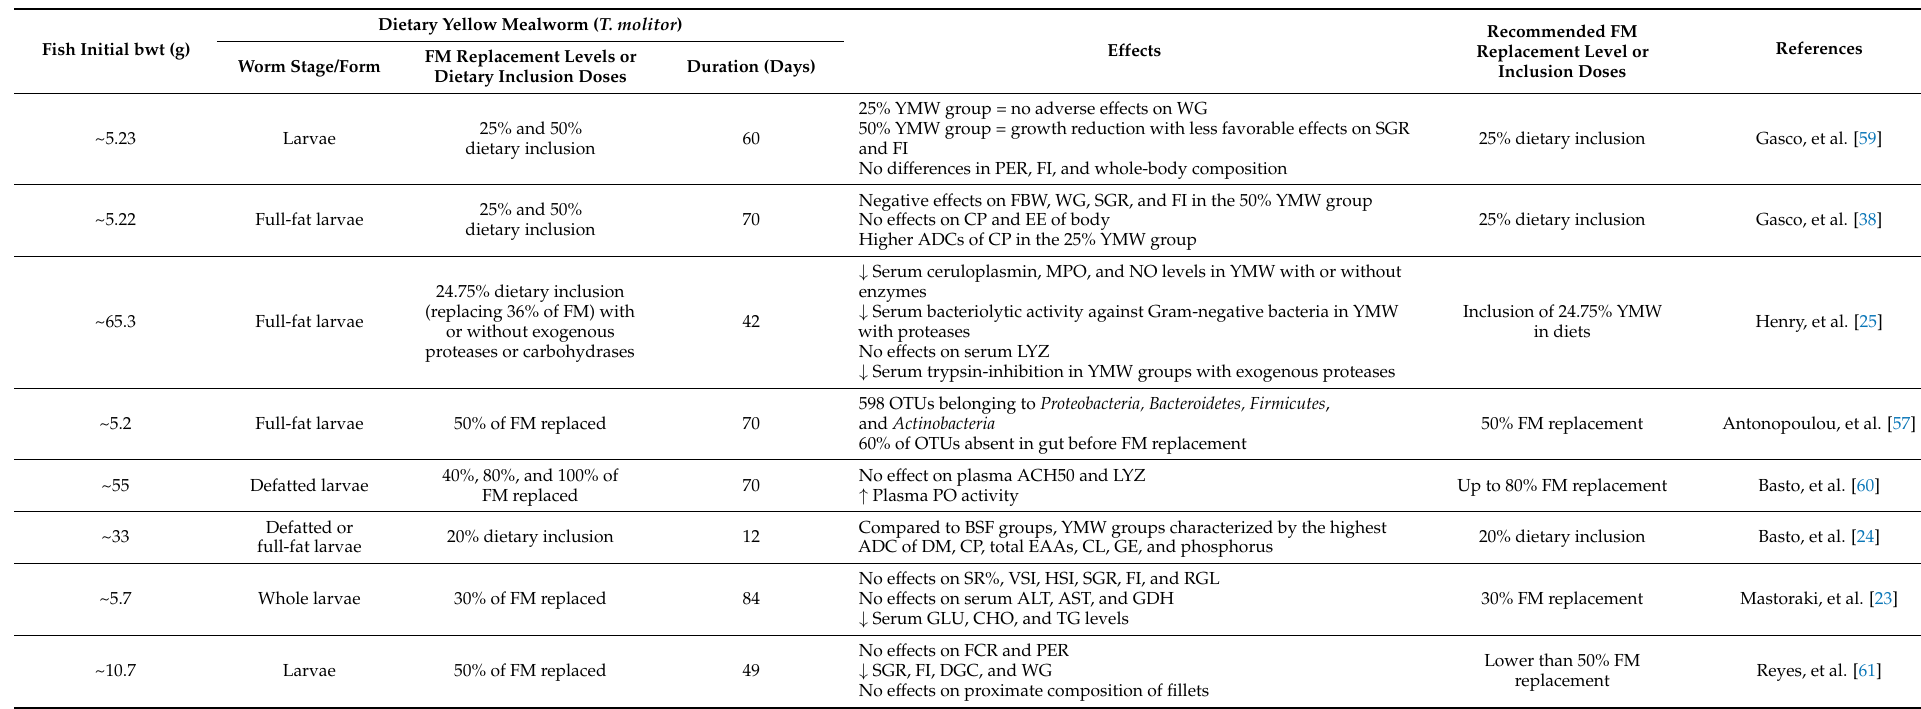
Table 5. Application and effects of using the yellow mealworm ( Tenebrio molitor ) in the diets of European sea bass ( Dicentrarchus labrax